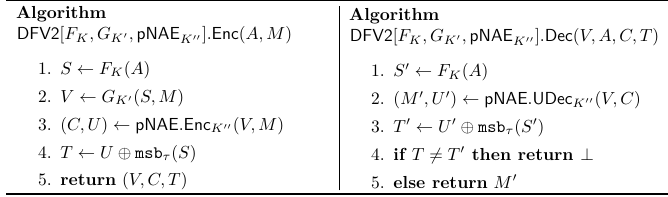
Figure 3: A Ciphertext-translation-based DFV ( DFV2 ). The functions F : K × A → S and G : K 0 × S × M → V are PRFs with S = { 0 , 1 } n 0 and V = { 0 , 1 } ν , and pNAE is a pNAE having a ν -bit nonce space. Tag T is τ bits satisfying n 0 ≥ τ .